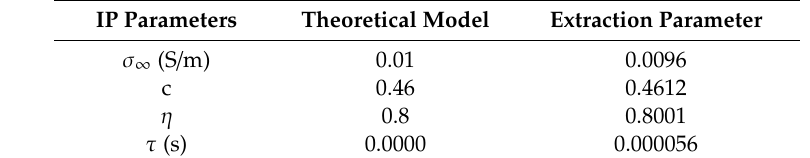
Table 2. Extraction results of polarization parameters with layered model. Induced polarization (IP).